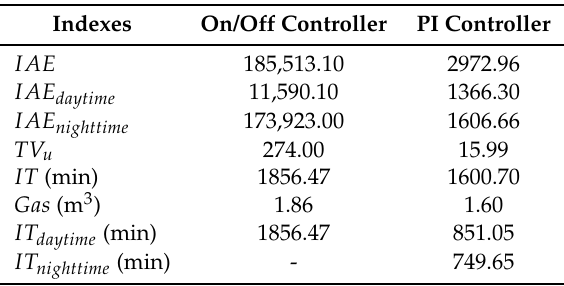
Table 1. Performance On/Off and Proportional-Integral (PI) control indexes.